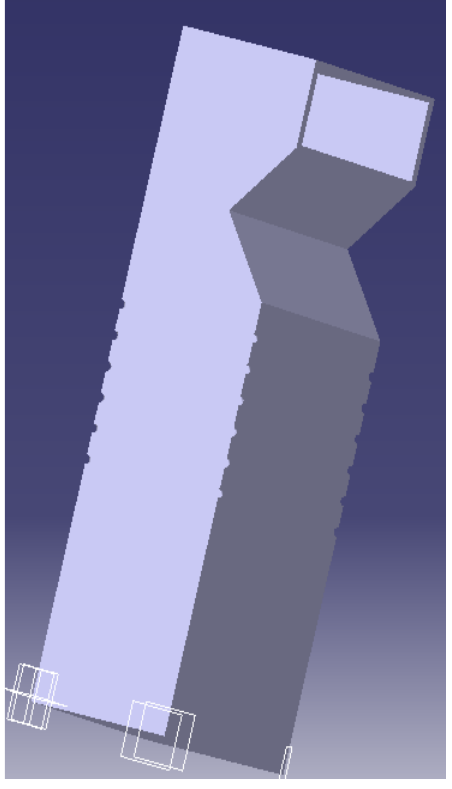
Figure 6. Supercritical Boiler side elevation geometry.